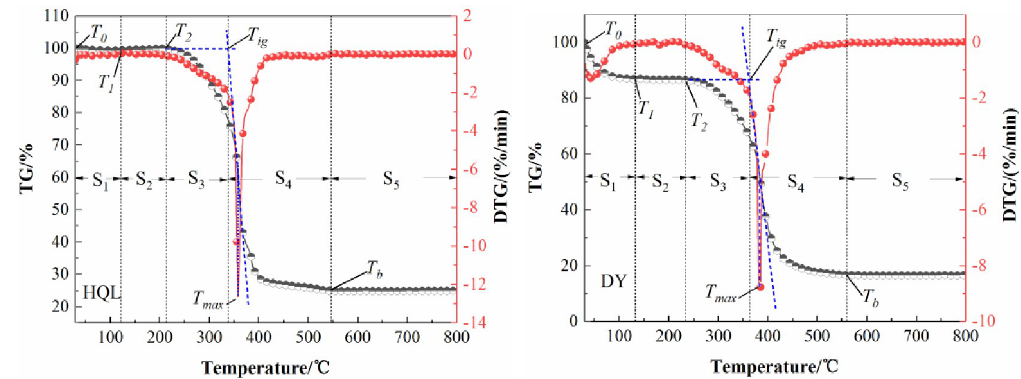
Fig 3. TG and DTG curves of the two coal samples studied.